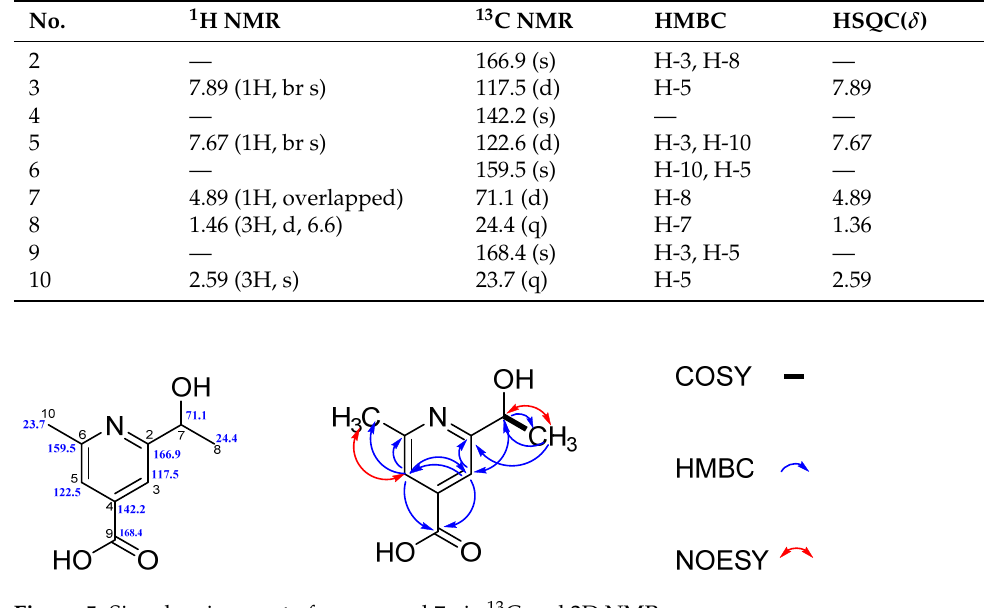
Figure 6. Experimental ECD spectra (200–400 nm) of 7 in methanol and the calculated ECD spectra of the model molecules of 7 at the PBE0/def2-TZVP level. Table 2. The 1 H, 13 C, HMBC, and HSQC NMR data for compound 7 in CD 3 OD. No.